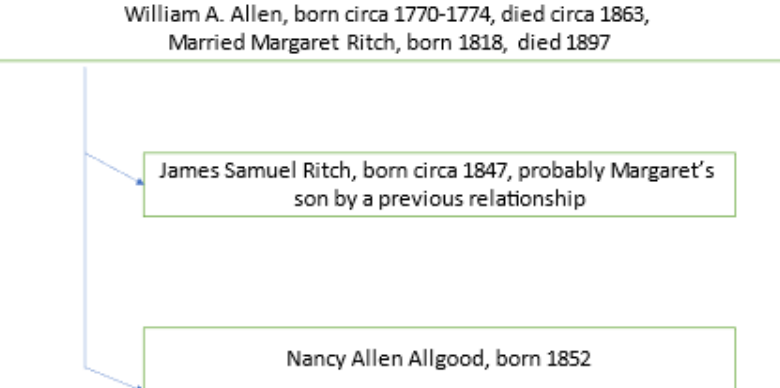
Figure 4. The Family of William A. Allen and Margaret Ritch. This chart identifies two children of Margaret Ritch Allen, as discussed in this article. James Samuel Ritch was probably not William Allen’s biological son, but he grew up from infancy in William Allen’s household. Nancy Allen Allgood’s daughter Olivia V. Allgood lived from 1881 to 1970, approximately 200 years after Wil- liam A. Allen’s birth. She may have contributed information used by Anita Sams in Wayfarers in Walton